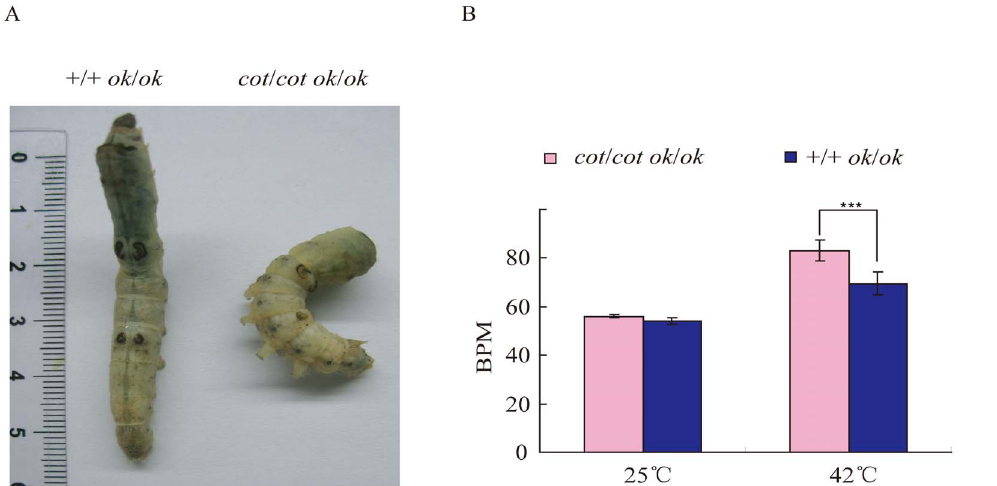
Figure 1. The heartbeat of cot mutants. (A) The transparent cuticle phenotype in cot mutants ( cot/cot ok/ok ) and controls ( + / + ok/ok ). (B) The heartbeat of cot/cot ok/ok and + / + ok/ok strains at room temperature and after 42 ˚ C for 3 min. Ten individuals were investigated for each genotype group with three replicates. BPM, beats per minute. Error bars indicate the SEM. Statistically significant differences were identified using Student’s t -test; p ,